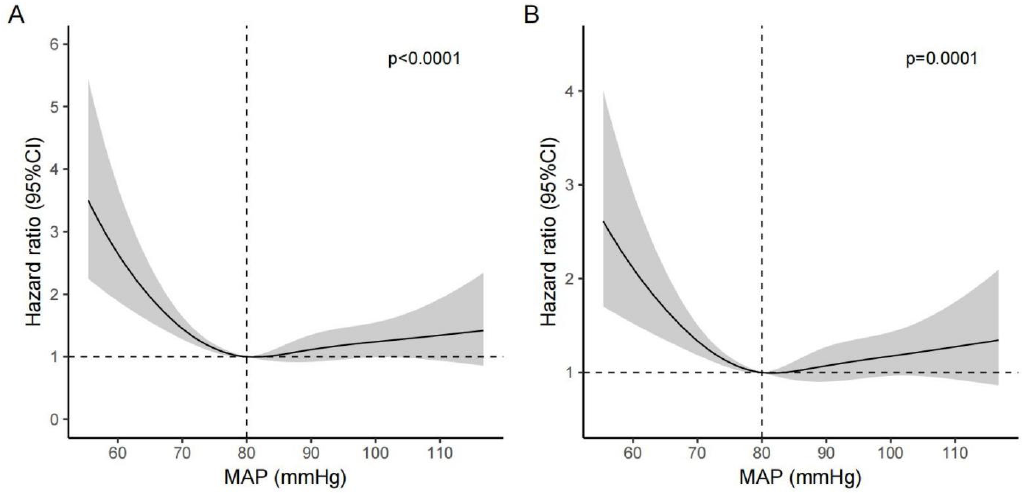
Figure 2. Crude non-linear association between MAP and the 7-day mortality ( A ) and 28-day mortality ( B ) in patients with acute stroke. The reference (hazard ratio = 1, horizontal dotted line) was an MAP of 80 mmHg (vertical dotted line).